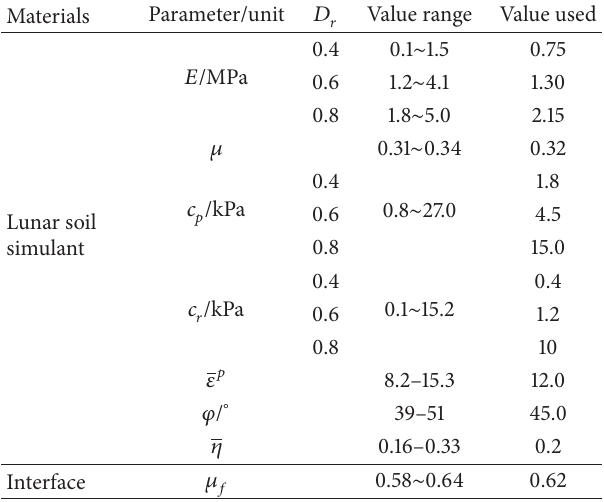
Table 6: Parameters of interface and lunar soil simulant selected in numerical